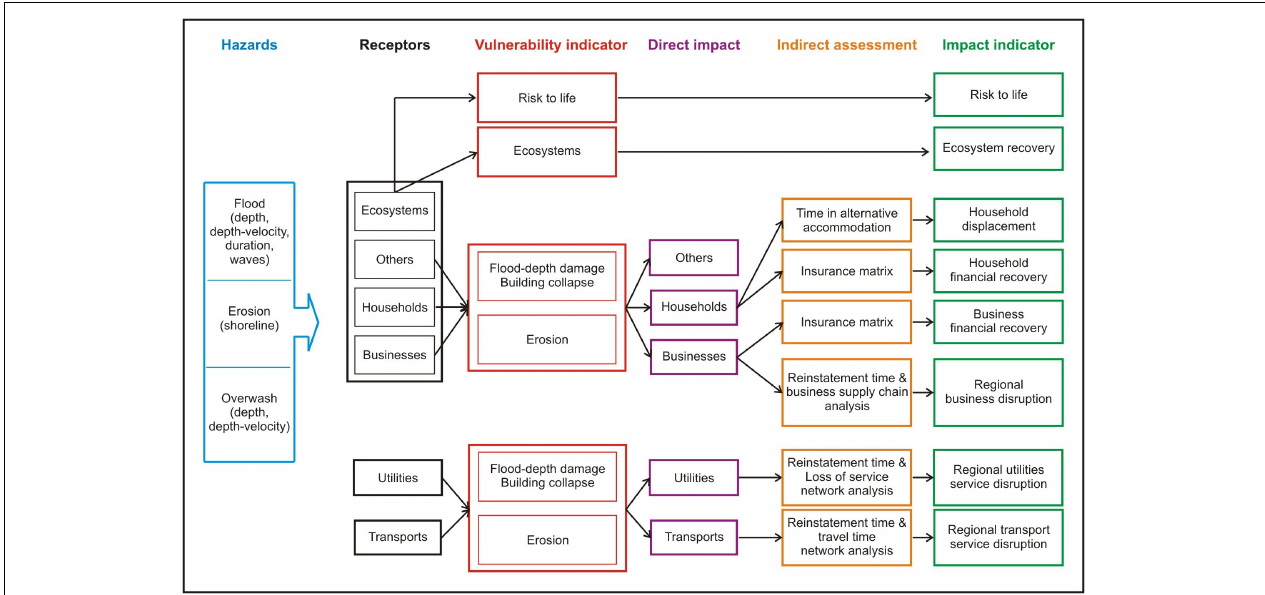
FIGURE 3 | Impact assessment process of the INDRA model (modified from Viavattene et al.,